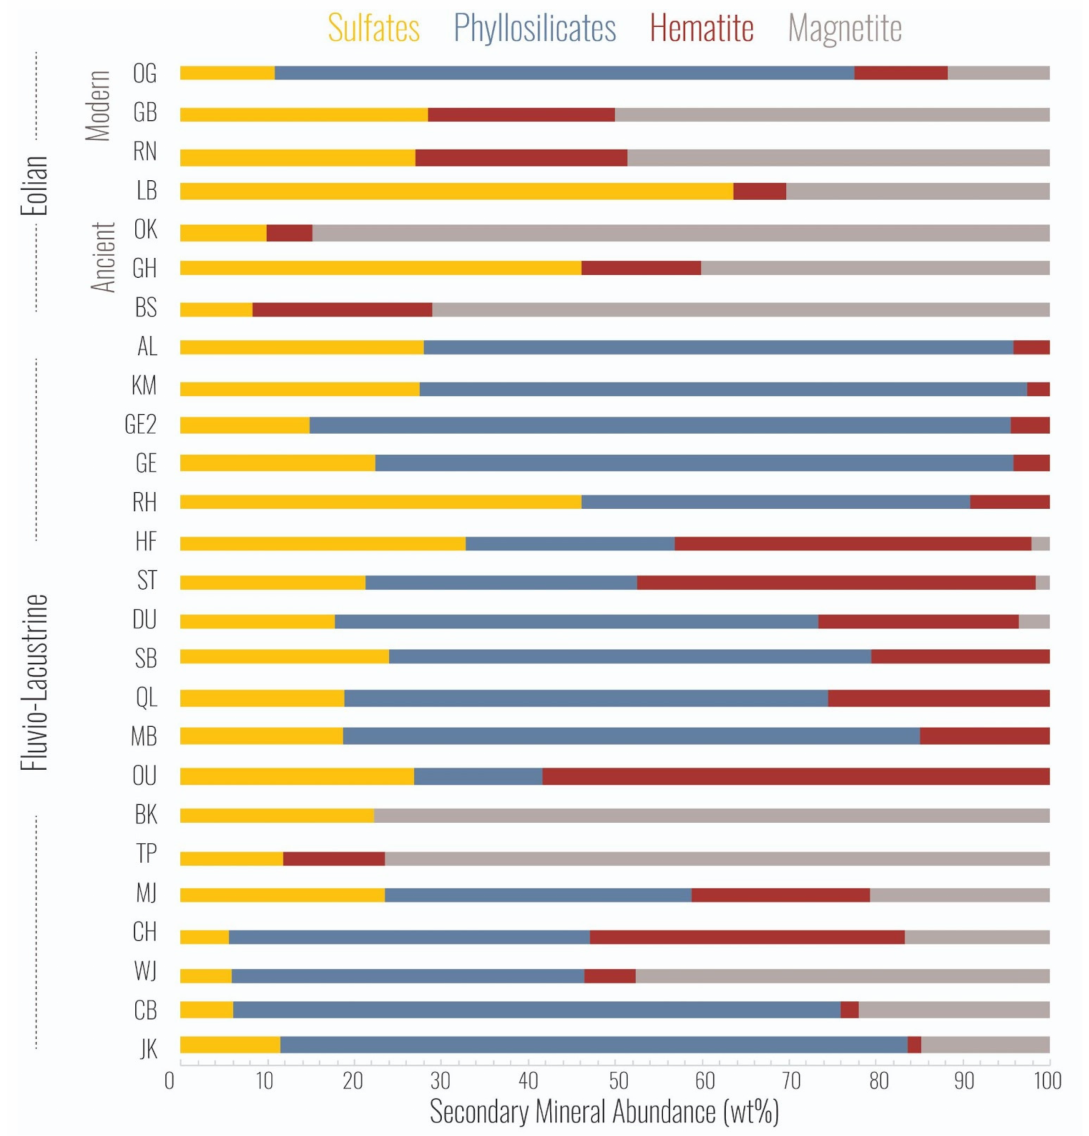
Figure 4. Major secondary mineral abundances, normalized to 100 wt%, for all CheMin analyzed drill samples to date. Sample abbreviations are as follows; John Klein (JK), Cumberland (CB), Windjana (WJ), Confidence Hills (CH), Mojave2 (MJ), Telegraph Peak (TP), Buckskin (BK), Oudam (OU), Marimba (MB), Quela (QL), Sebina (SB), Duluth (DU), Stoer (ST), Highfield (HF), Rockhall (RH), Glen Etive (GT), Glen Etive 2 (GE2), Kilmariee (KM), Aberlady (AL), Big Sky (BS), Greenhorn (GH), Okoruso (OK), Lubango (LB), Rocknest (RN), Gobabed (GB), and Ogunquit Beach (OG). Depositional environment is indicated on the left: OG-RN are modern eolian, LB-BS are ancient eolian, and AL-JK are fluvio-lacustrine. Additional secondary phases, including opaline silica, akaganeite, and carbonate, have also been detected but are not as abundant and are not shown